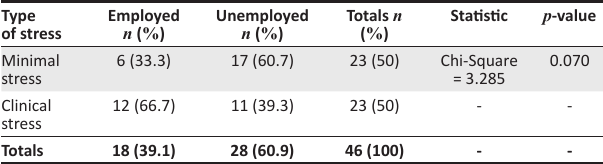
TABLE 5: Association between caregiver distress and employment status ( N = 46).